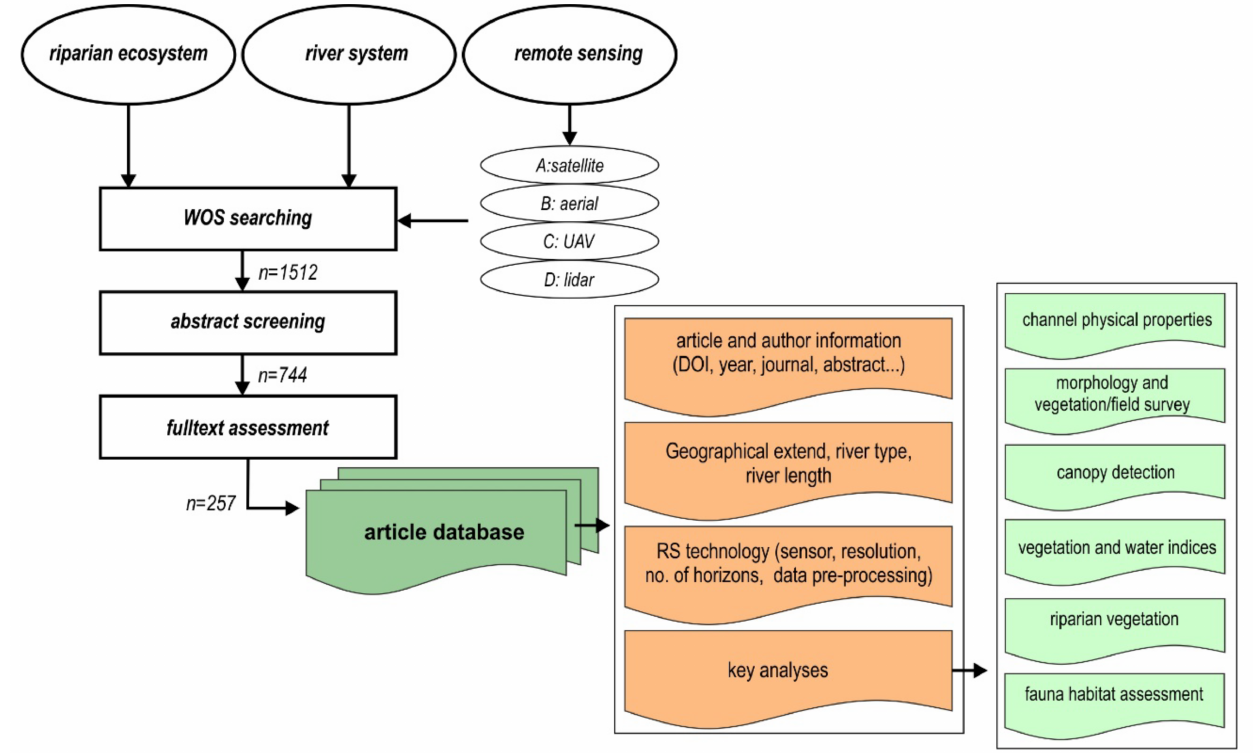
Figure 1. Workflow diagram of article extraction from the WOS database and article